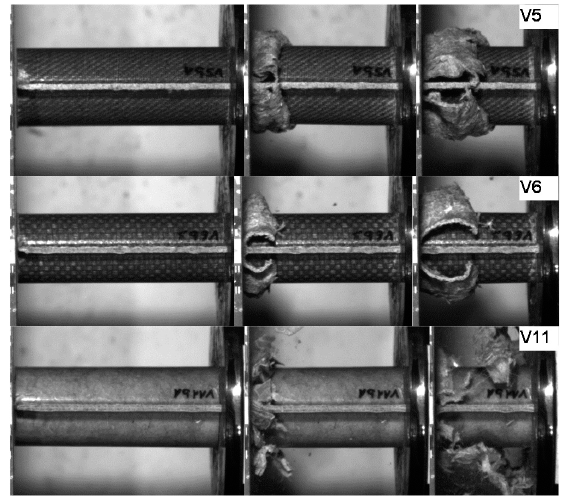
Figure 10. Failure mechanism of V5, V6 and V11 in crash tests series b.